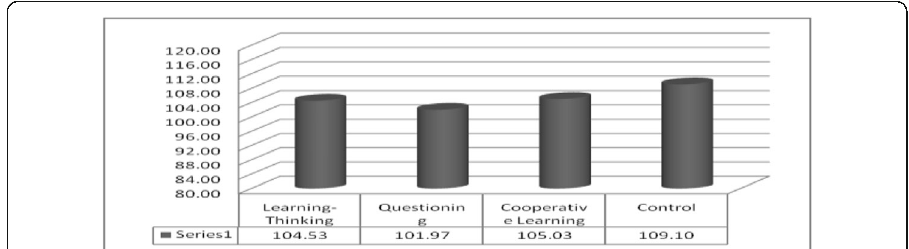
Fig. 1 Means on pretest of level of autonomy by